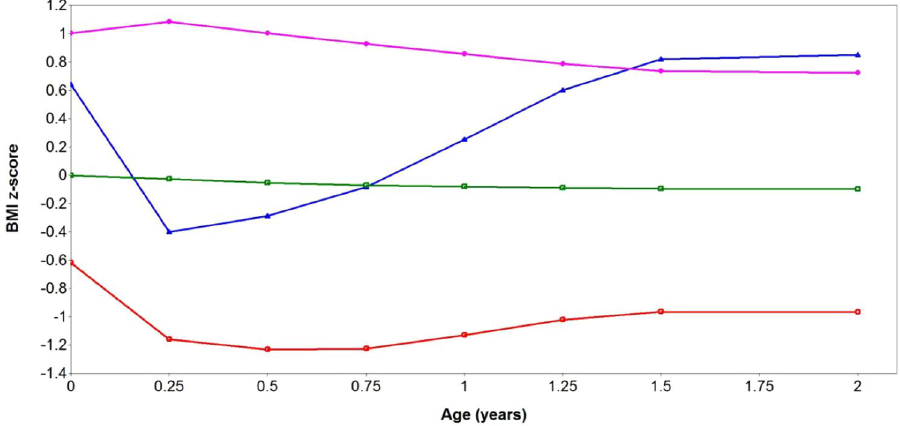
Figure 1. BMIz trajectories in the first 2 years of life in the GUSTO cohort. Red line = stable low BMIz trajectory (n = 155); Green line = Normal BMIz trajectory (n = 857); Purple line = stable high BMIz trajectory (n = 100); Blue line = Rapid BMIz gain after 3 months trajectory (n = 58). Values indicate mean BMIz at each time